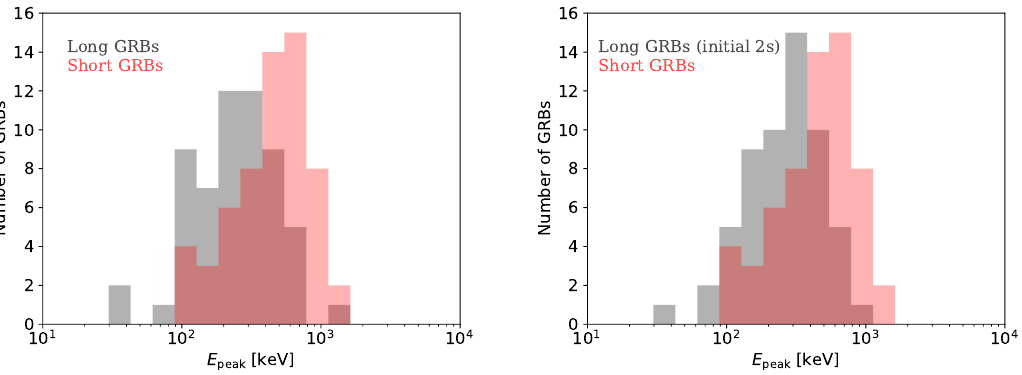
Figure 3. Histograms of E peak between short GRBs and long GRBs ( left ), and short GRBs and the initial 2 s of long GRBs ( right